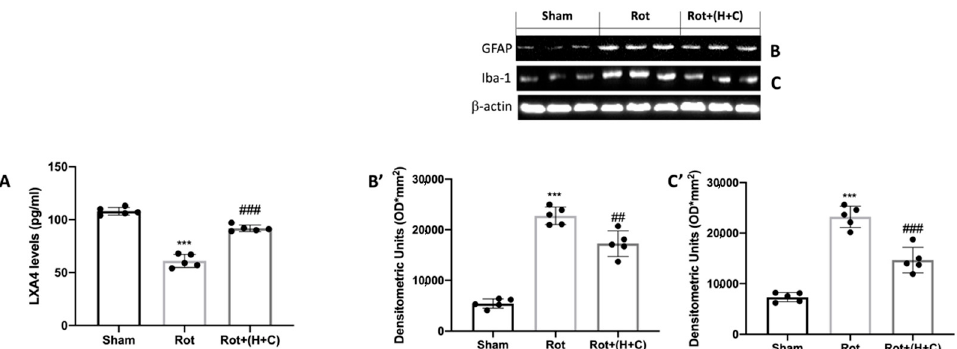
Figure 2. Effects of H+C on LXA4 levels and on astrocytes and microglia after Rot intoxication. LXA4 protein levels in midbrain were evaluated via ELISA kit in Sham, Rot and Rot+(H+C) groups ( A ). Western blot analysis revealed, compared with Sham group, an evident increase in GFAP ( B ) and Iba-1 ( C ) in Rot-treated mice. Animals subjected to treatment with H+C revealed a significant decrease in astrocytes ( B ) and microglia ( C ). See the respective densitometric graphs ( B’ , C’ ). Values are expressed as mean ± SD of three independent analyses on 5 animals/group. *** p < 0.001 compared to Sham; ## p < 0.01 compared to Rot; ### p < 0.001 compared to Rot.